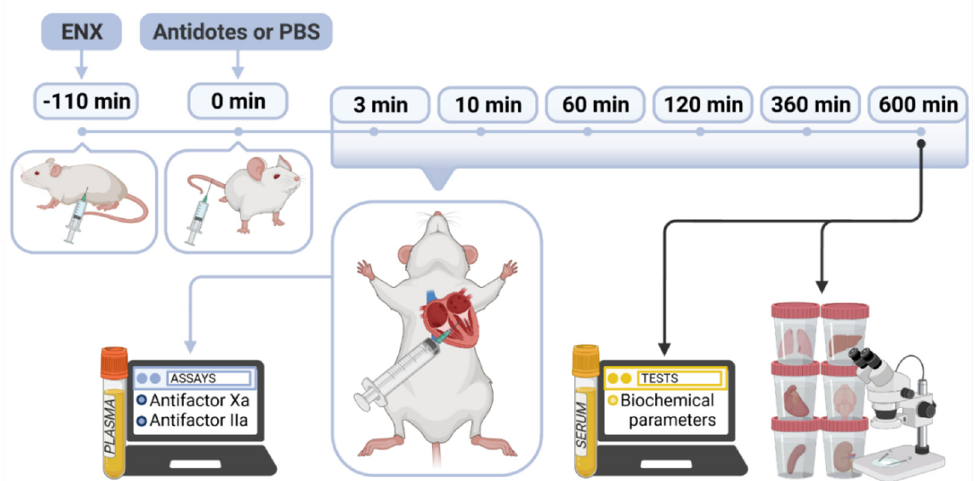
Figure 5. Schematic representation of the study protocol. The diagram shows the time-course of events from enoxaparin (ENX) subcutaneous administration and injection with vehicle (PBS) or antidotes: HBC (6.25 and 12.5 mg/kg) or protamine sulfate (5 and 10 mg/kg) into the mice tail vein.